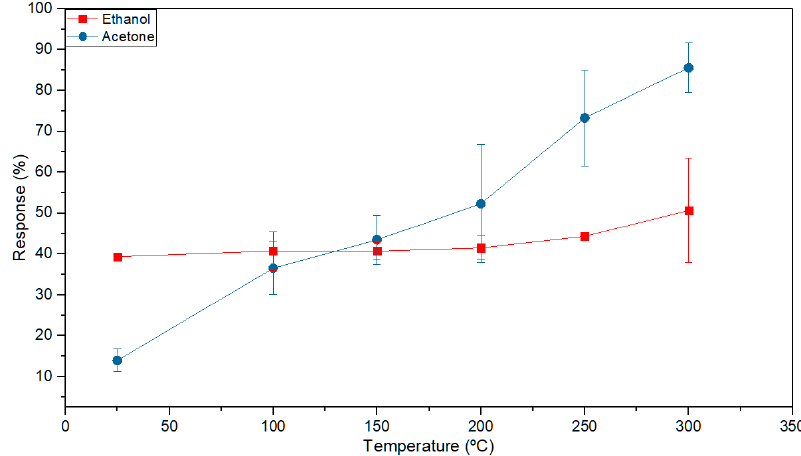
Figure 4. Sensor response 1 to 2 ppm ethanol and 4 ppm acetone at different operating temperatures in dry air (0% RH).